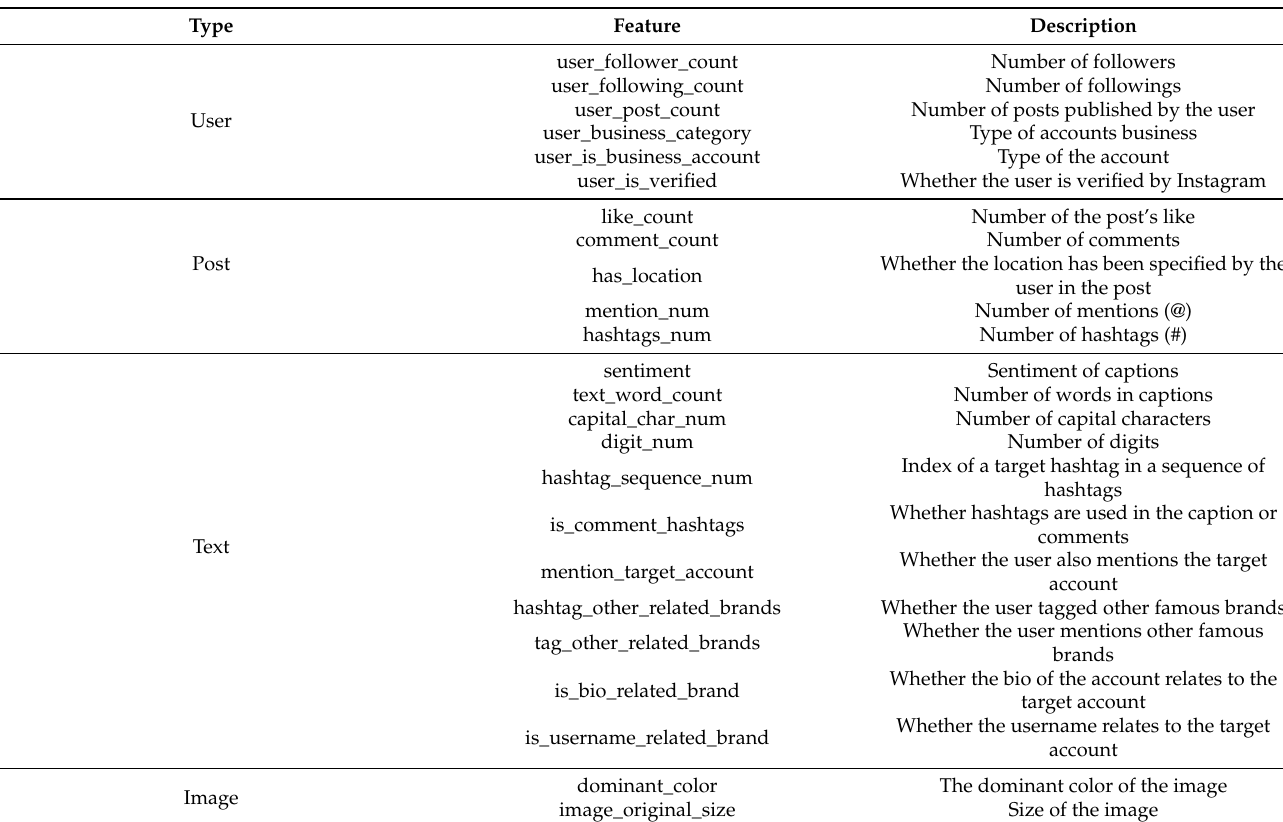
Table 3. List of extracted features with their